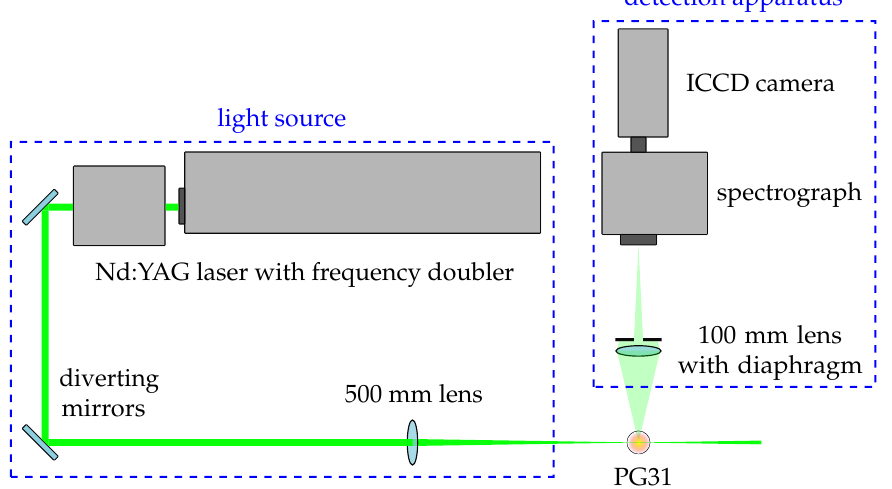
Figure 3. Schematic diagram of the experimental setup for laser scattering (not to scale). The entrance slit of the spectrograph is oriented horizontally.